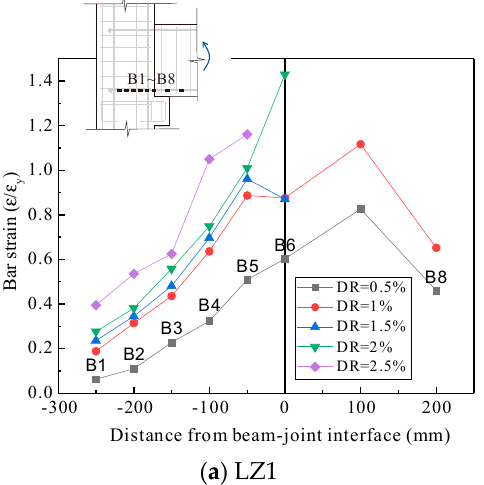
Figure 10. Secant stiffness degradation.